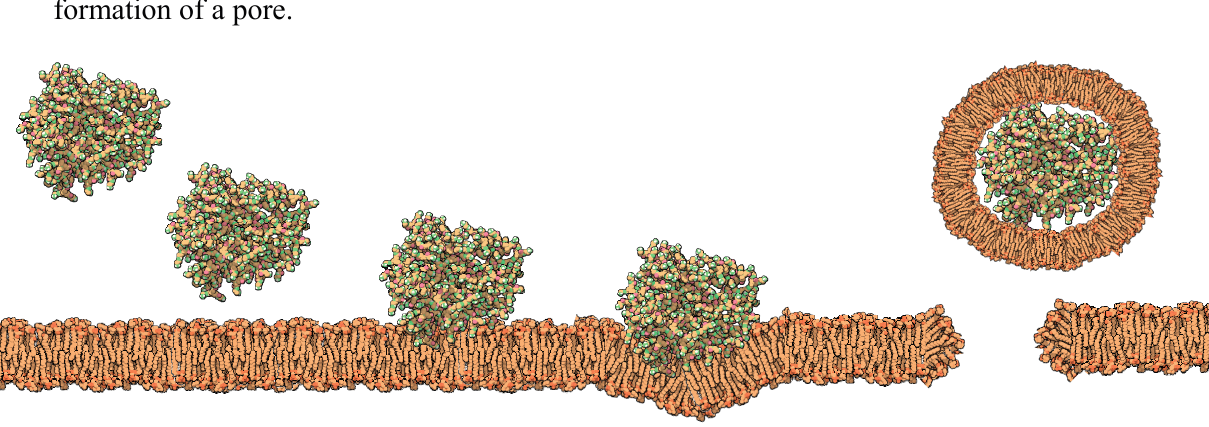
Figure 8. Proposed mechanism for high generation of PAMAM dendrimers; there is an initial attraction to the membrane governed by several forces (e.g., electrostatic); once the dendrimer is near the membrane the inner leaflet promotes interactions with the dendrimer. For high generation, the dendrimer is not able to flat and causes perturbation on the membrane leading to the formation of a vesicle encasing the dendrimers with subsequent formation of a